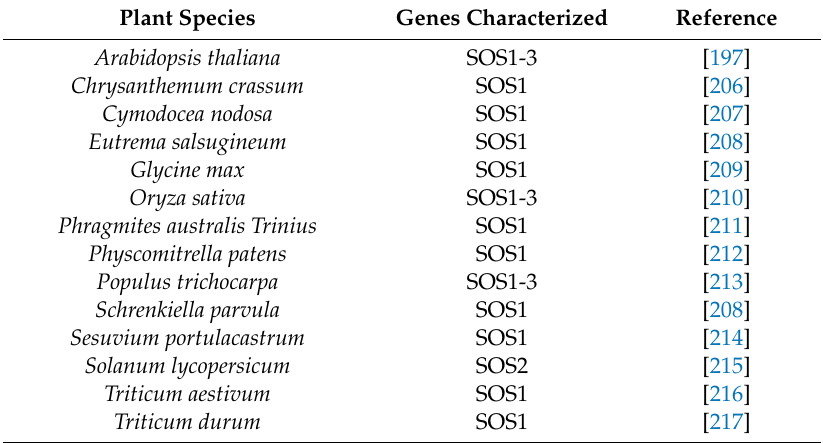
Table 6. SOS genes from various plant species characterized in